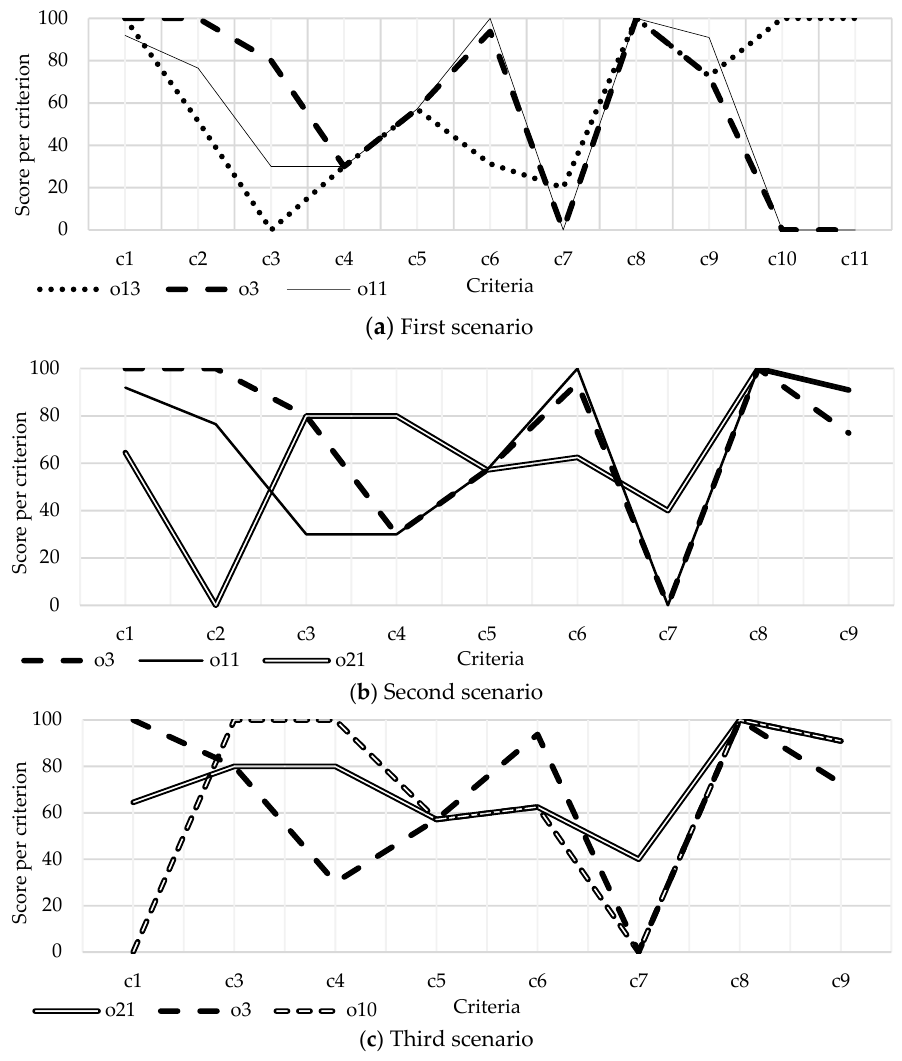
Figure 3. The canvas of value curves of the three most attractive offers per each of the scenarios.